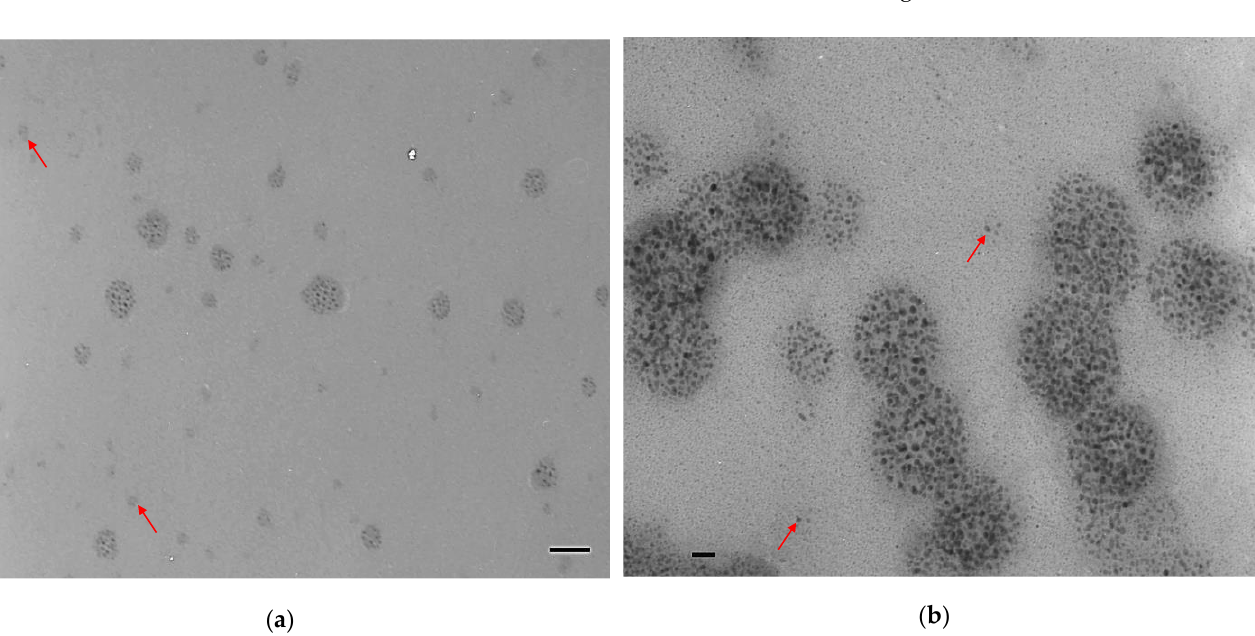
Figure 7. Schematic cross-section representation of Pd loaded micelles formed in water by solvent displacement: ( a ) Monomolecular (G1) 2 −PEG5k−(G1) 2 micellar Pd complex; ( b ) Multimolecular (G1) 2 −PEG5k−(G1) 2 micellar Pd complex.